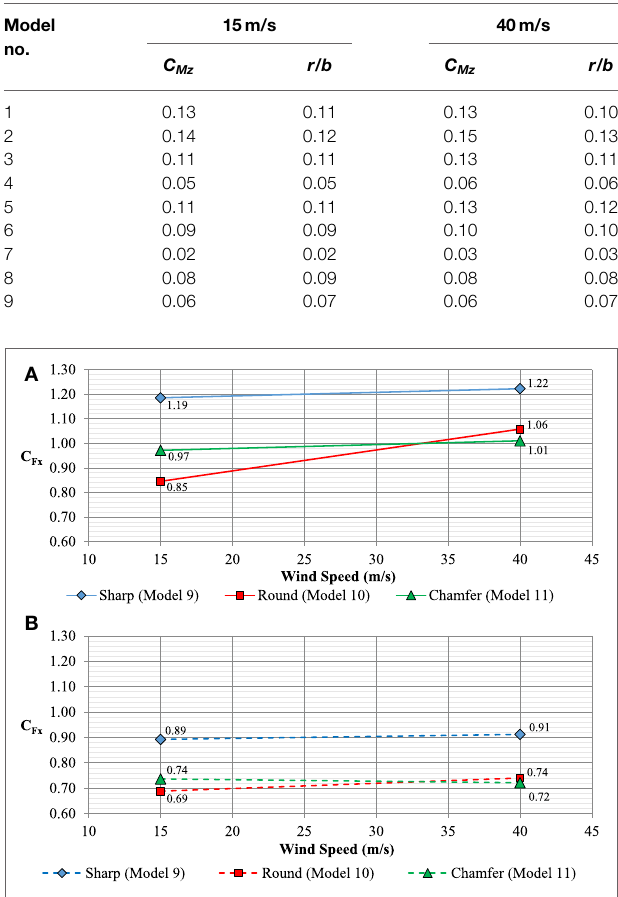
FIGURE 7 | Comparison of sharp and modified corner results: (A) 0°; (B) 45°.